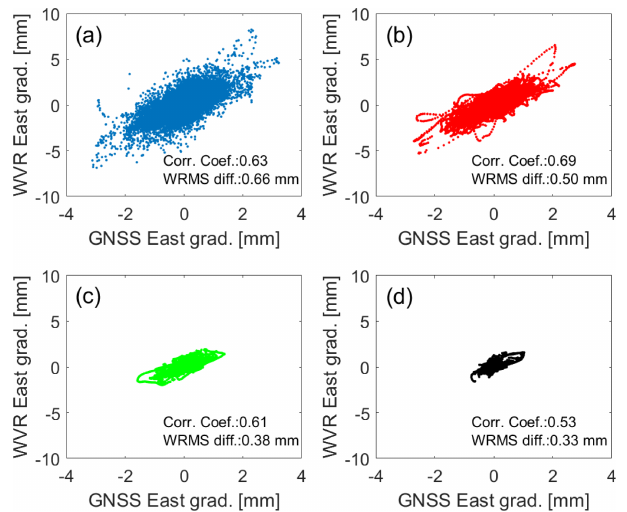
Figure 9. Correlations between estimated east gradients from the GNSS, given by the GRE solution with a 3 ◦ elevation cutoff an- gle, and the WVR data. Four different values of (cid:49)t eff are used: